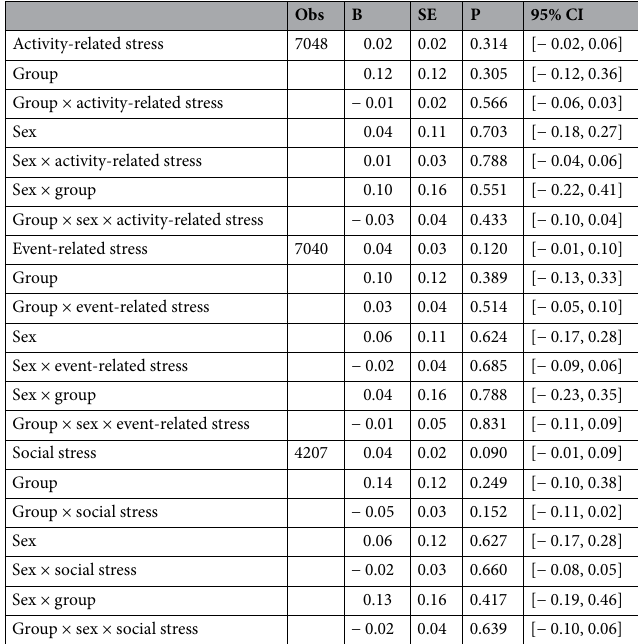
Table 4. Multilevel regressions estimate of stress, group, and their interactions in the model of cortisol. Obs, number of observations; B, standardized regression coefficient; SE, standard error; CI 95%, 95% confidence interval. The dependent variable in all models is CORT (i.e., log-transformed cortisol). All models were controlled for hour, hour 2 , oral contraceptive use, age, and lifetime